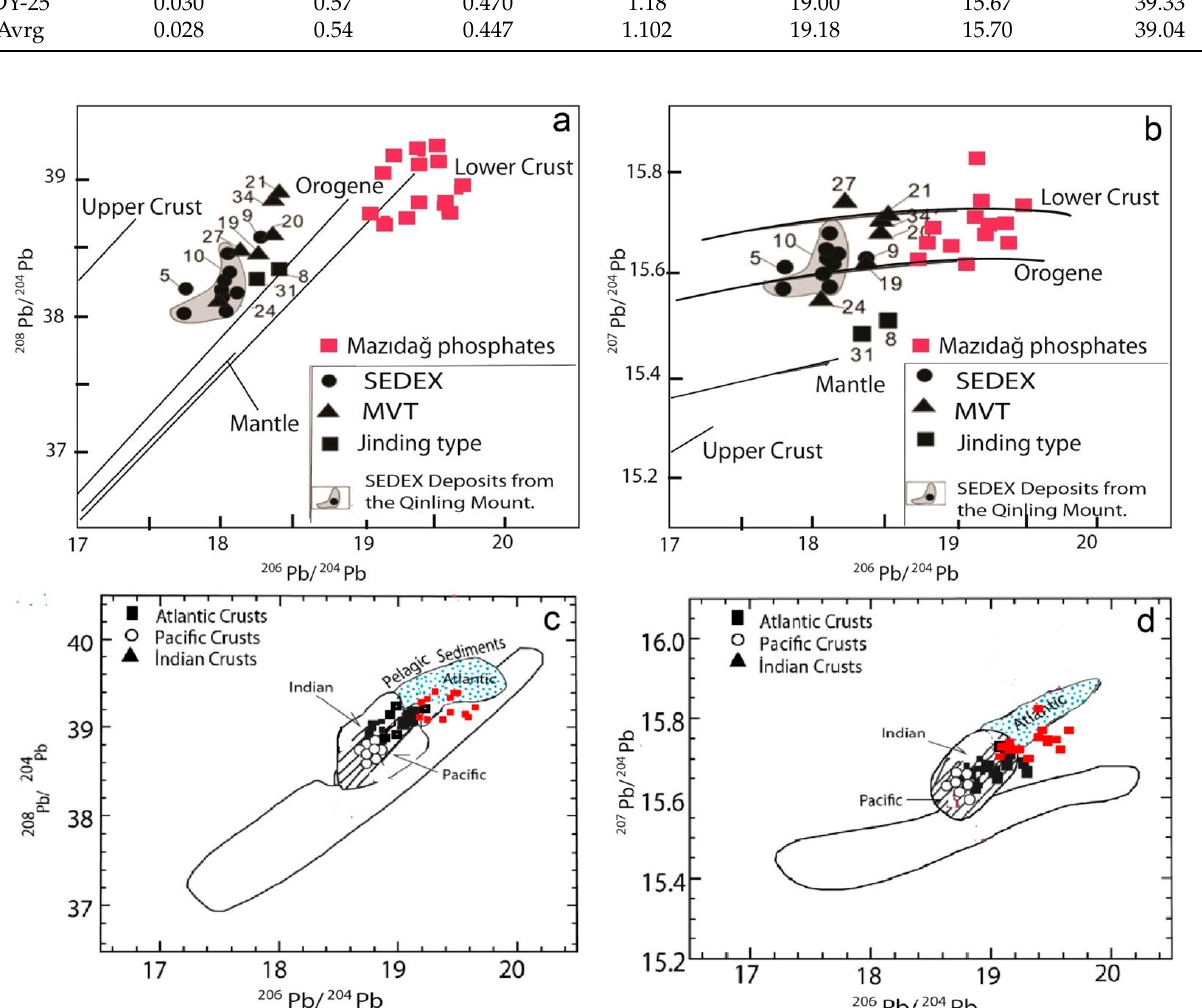
Figure 11. ( a , b ) Comparison of Pb isotopic compositions of the Maz ı da ğ ı phosphates with selected Chinese sediment-hosted Pb-Zn deposits, plotted in the plubotectonic model diagram of Zartman and Doe [90], and ( c , d ) comparison of Pb isotope compositions of the Maz ı da ğ ı phosphates with MORB, ferromanganese crusts, and pelagic sediments, and Pacific, Atlantic, and Indian oceans pelagic sediment. Data taken from [91,92].